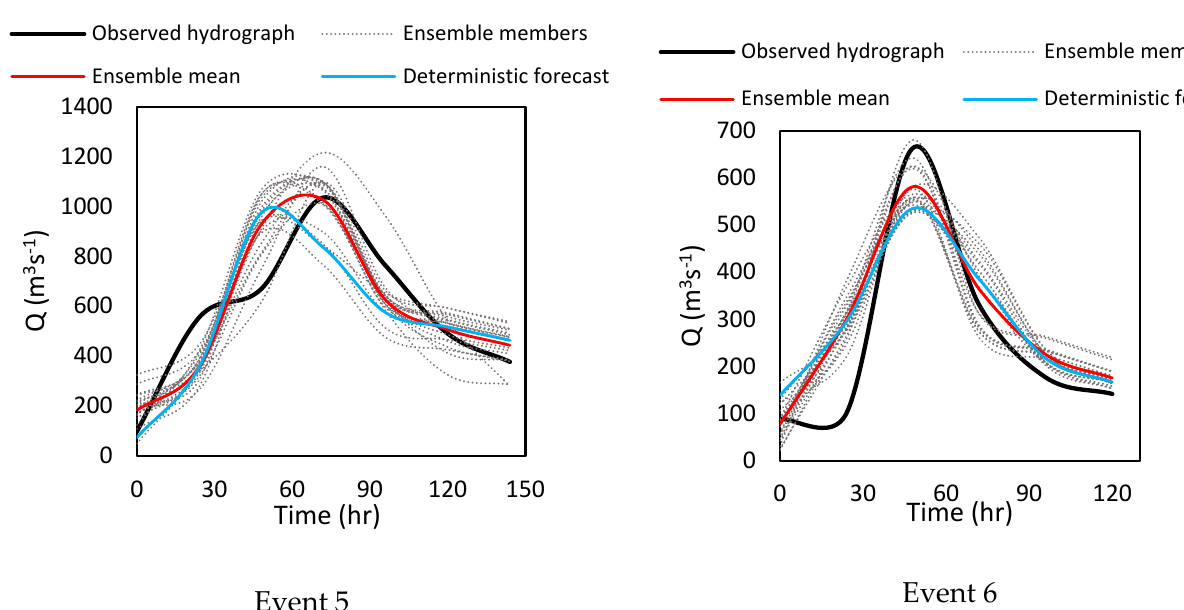
Figure 10. Ensemble reservoir inflow during flood events at the validation stage. Table 12 indicates the goodness-of-fit metrics for the HBV model at the validation stage. The results demonstrate that when post-processed ensemble precipitation forecasts are employed for reservoir inflow simulation by the HBV model, the NSE values are enhanced for all ensemble members and the ensemble-mean by an average of 5% and 16%, respectively, compared with the deterministic forecasts. In addition, the average values of MARE for all ensemble members and the ensemble-mean are decreased by 2% and 12%, respectively, in comparison with deterministic forecasts. Therefore, it can be asserted that the use of post-processed ensemble precipitation forecasts is effective in increasing the HBV model’s efficiency for reservoir inflow forecasts based on all goodness-of-fit metrics. Table 12. The goodness-of-fit metrics used for the HBV model to simulate ensemble reservoir inflow in the validation stage.